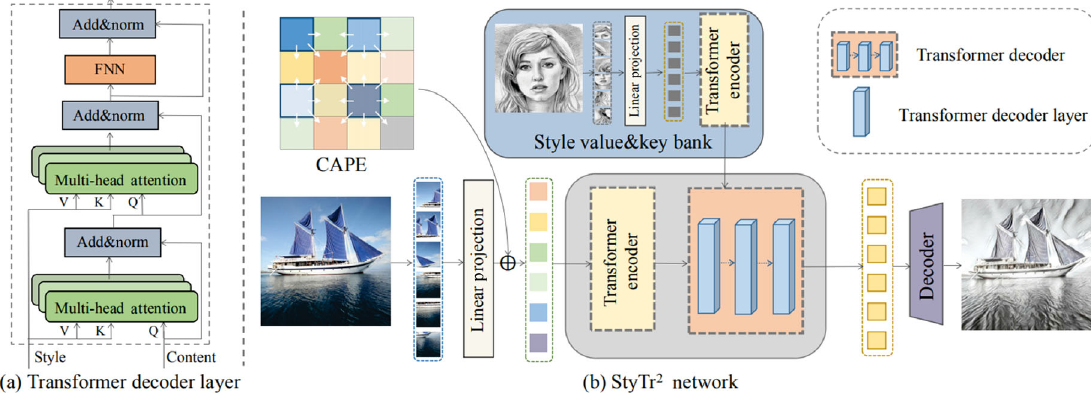
Fig. 21 Overview of StyTr 2 . Reproduced with permission from Ref. [38], c (cid:2) The Author(s)